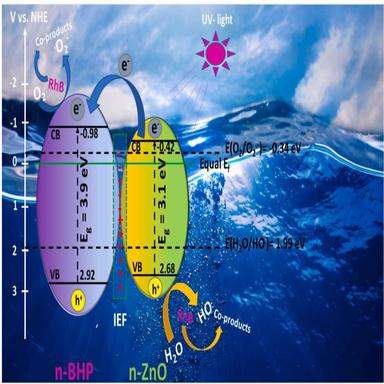
Proposed mechanism for RhB degradation by BHP@ZnO.